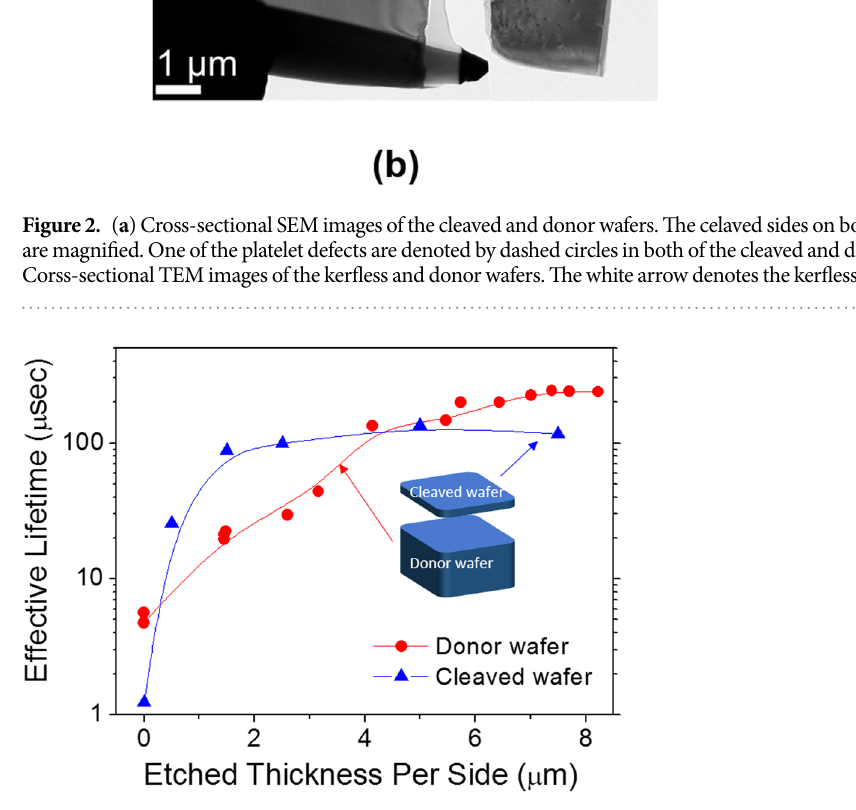
Figure 4(c) shows the EQE values in the short wavelength region below 600 nm improves, supporting the implantation damage is removed by etching. Note that the as-cleave based wafer solar cell shows slightly higher EQE values above the wavelength of 800 nm compared with the etched wafers, which might be caused by the slightly larger thickness of the as-cleaved wafer and also light scattering due to its higher surface roughness.